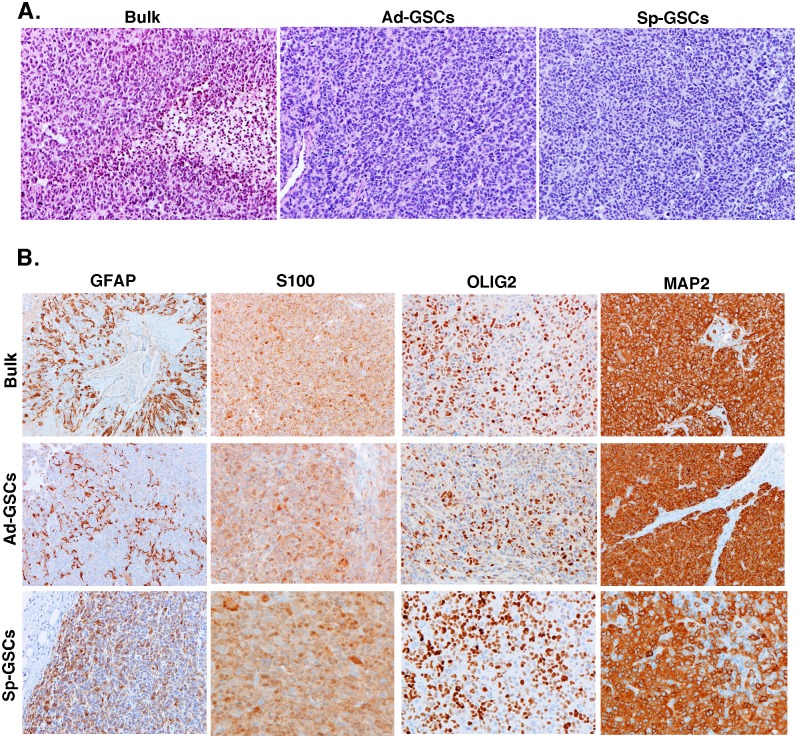
Pathologic analysis of subcutaneous GBM6 tumor xenografts.GBM6 bulk tumor cells, Ad-GSCs, and Sp-GSCs were injected subcutaneously and allowed to grow to a diameter of ~400mm3. Tumors were harvested and paraffin embedded for histology. A. H&E staining and B. Immunoreactivity for GFAP, S100, OLIG2 and MAP2. (All photomicrographs taken at 200x).